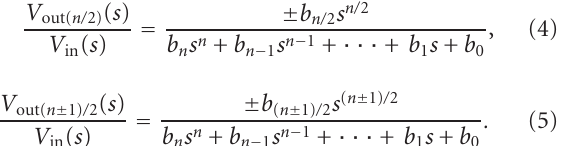
functions of symmetrical and asymmetrical responses for each of the configurations are as